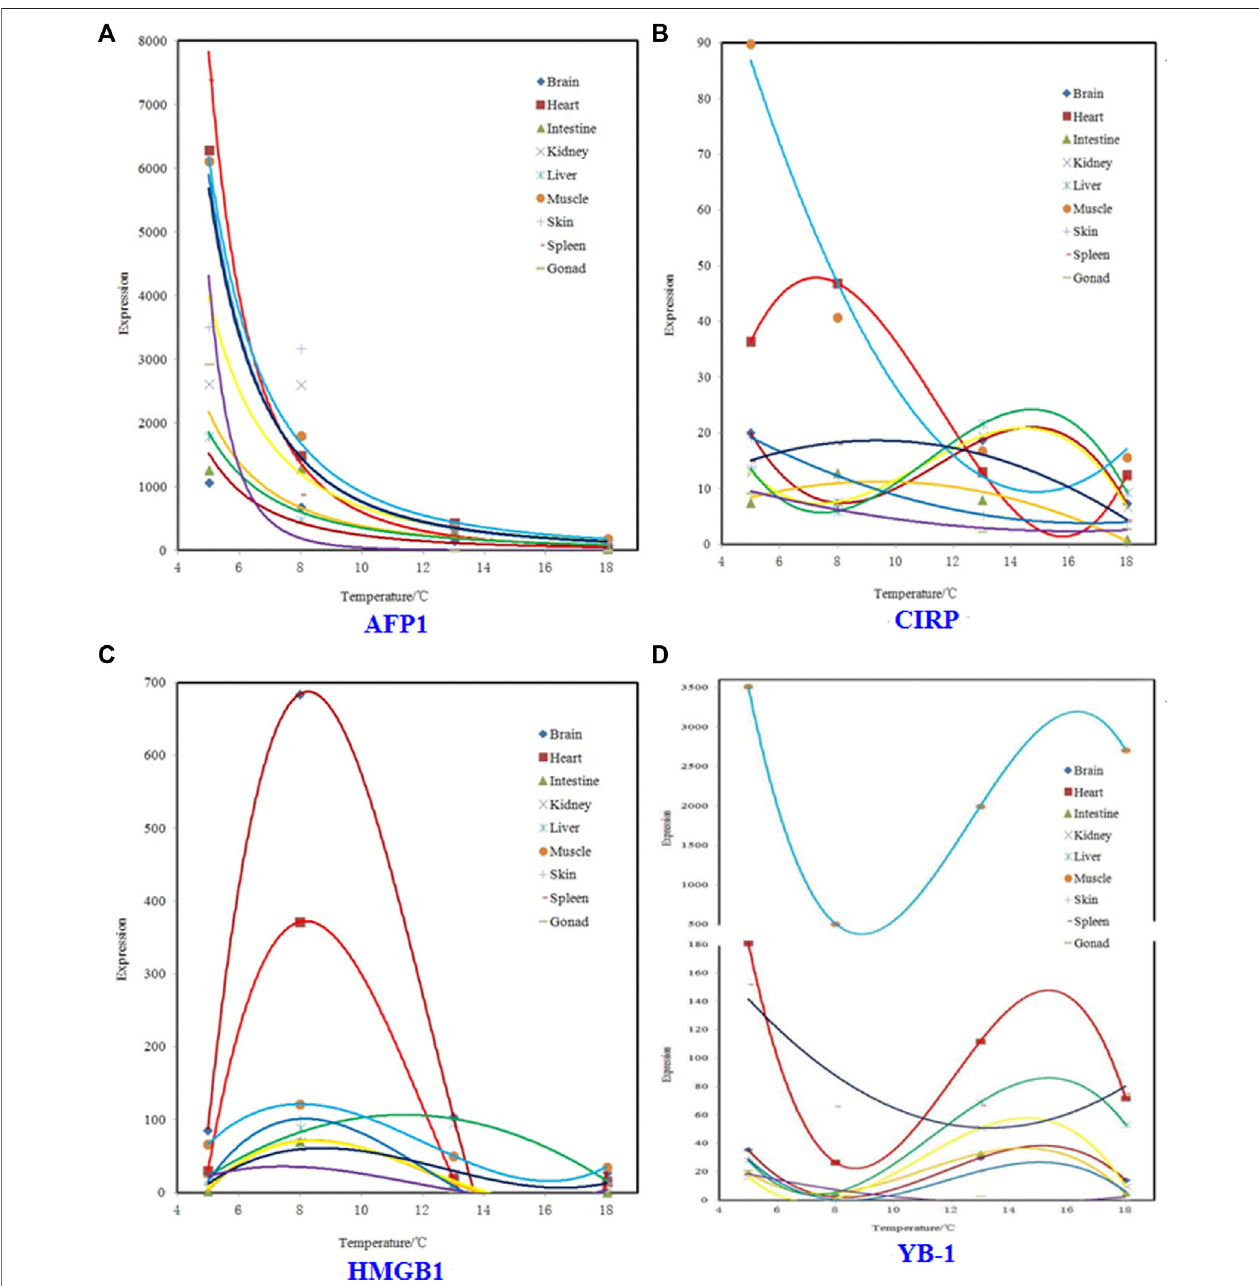
FIGURE 1 | Regression models for relation between expression and temperature for four